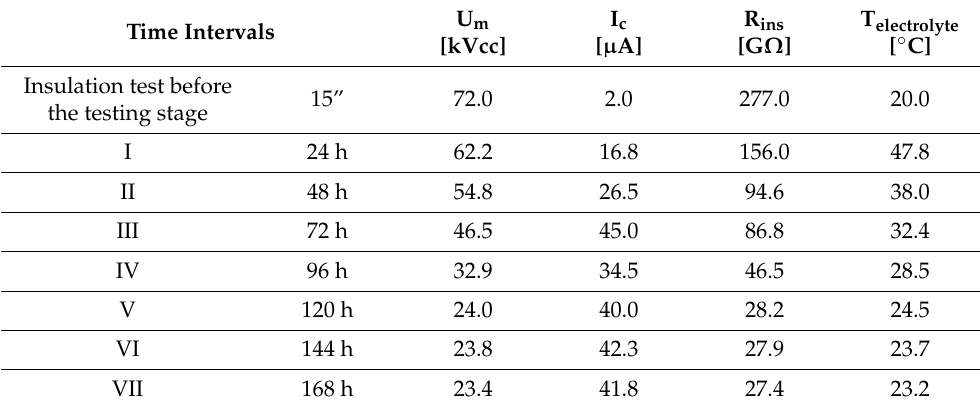
Table 1. Constant measured size values in the first stage of the experimental study.